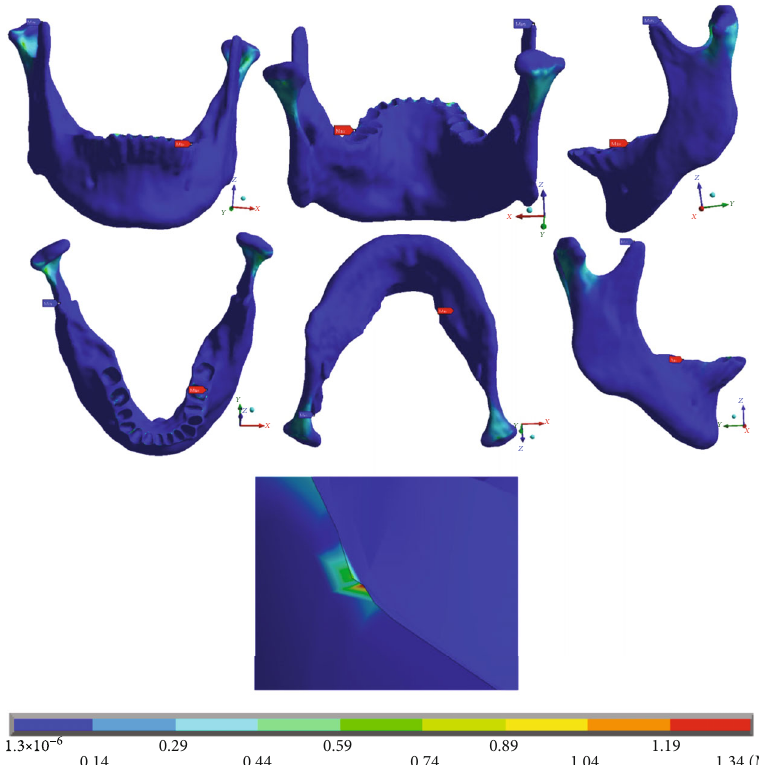
Figure 21: von Mises stresses on the mandibular bone. The red marker indicates the maximum stresses, and the blue marker indicates the minor stresses.